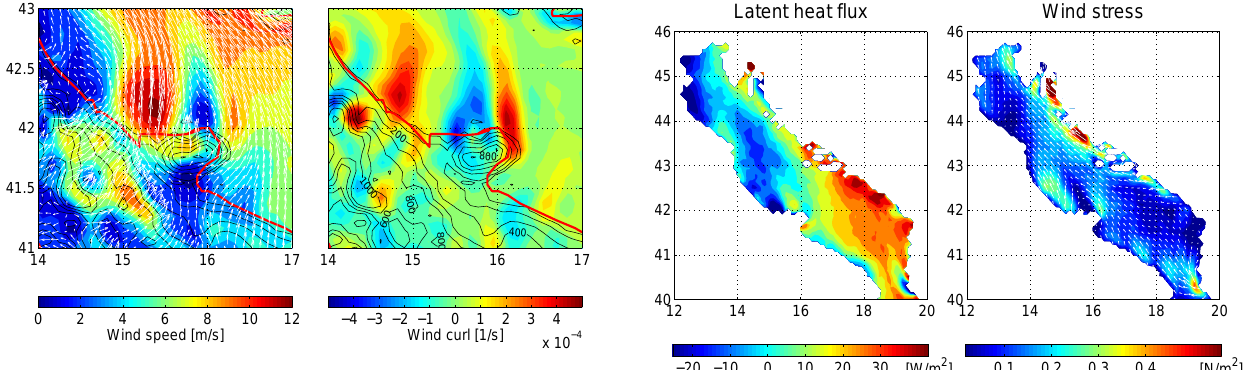
Fig. 5. ALADIN-ECMWF mean differences for latent heat flux and wind stress (vectors and shaded) over the 63 sirocco